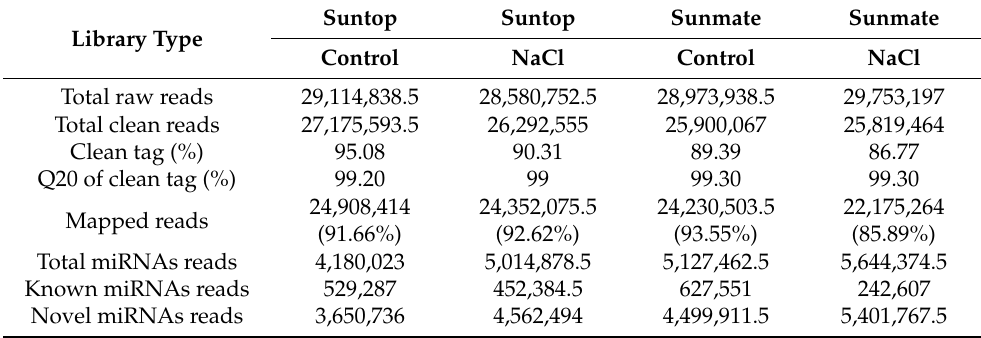
Table 1. Summary of high-throughput sequencing of small RNAs from the roots of the two wheat cultivers Suntop and